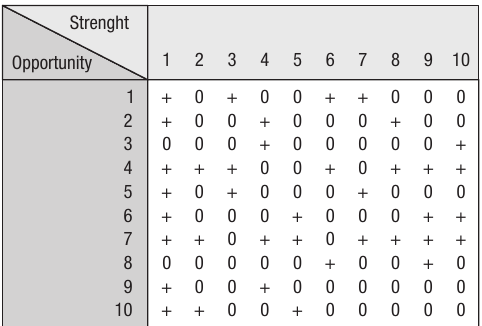
Fig. 5. Interaction matrix (Weihrich